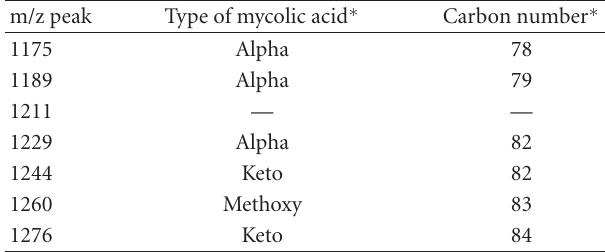
Table 1: Antimycobacterial and cytotoxicity of lignans and oxadia- zolines.